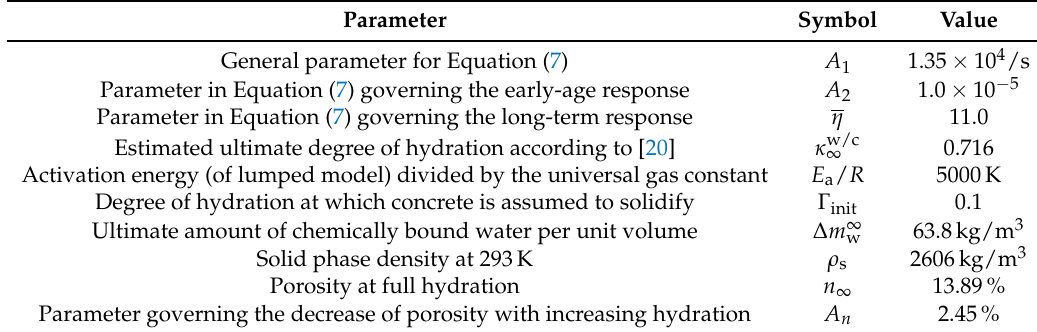
Table 3. Parameters for the hydration model and the porosity evolution